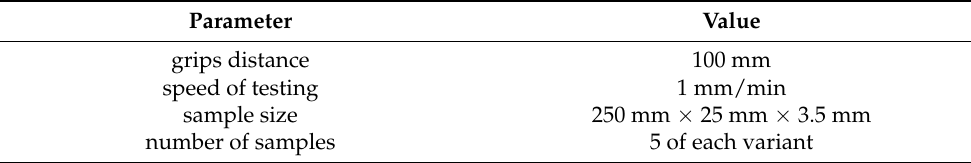
Table 3. Tensile strength tests and tensile elongation test parameters [24].